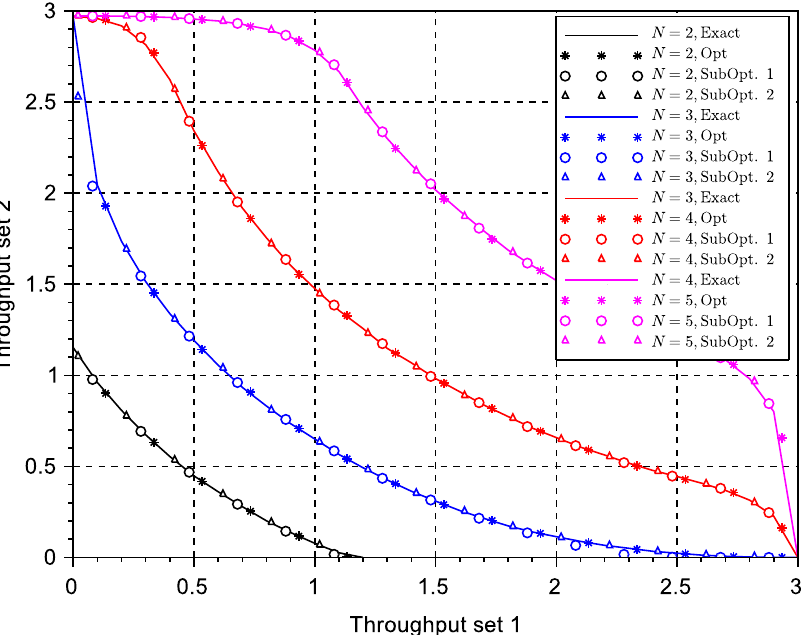
Figure 2. Throughput region of a multi-packet reception (MPR) system with two subsets of terminals: J 1 = J 2 = 3 using the N -reception model with different values of N